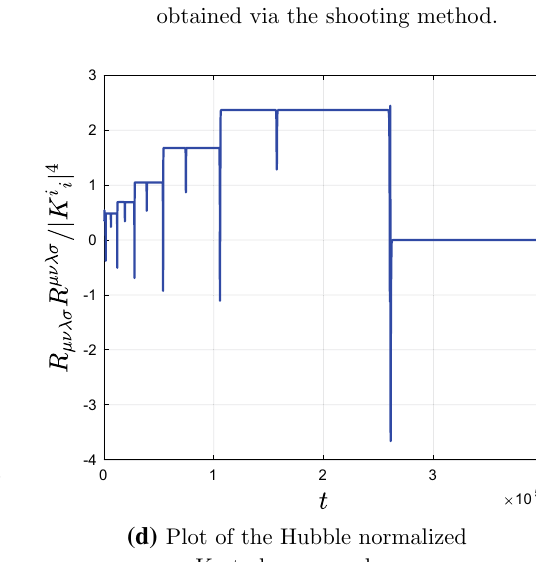
( a ) Plot of the function 16 u 2 (1+ u ) 2 (1+ u + u 2 ) 3 on the right hand side of (31).